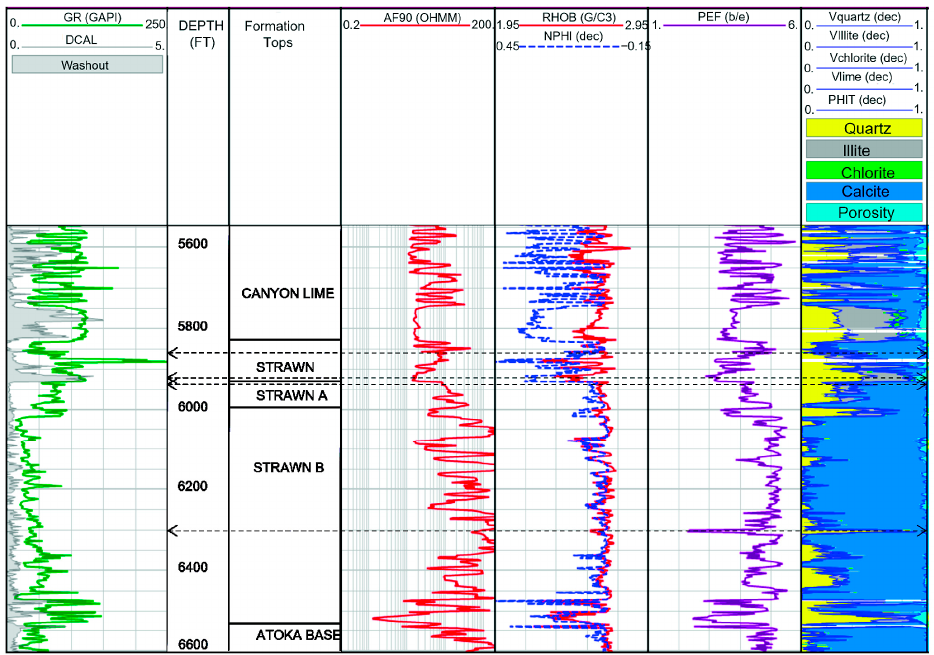
Figure 19. Well log analysis for well 6 showing entire Strawn interval composed of mostly calcite (carbonate) with few thin shale and sandstone stringers. Overall, interval has low porosity. Note: dashed double-headed black arrows = selected rotary core-sample depths.